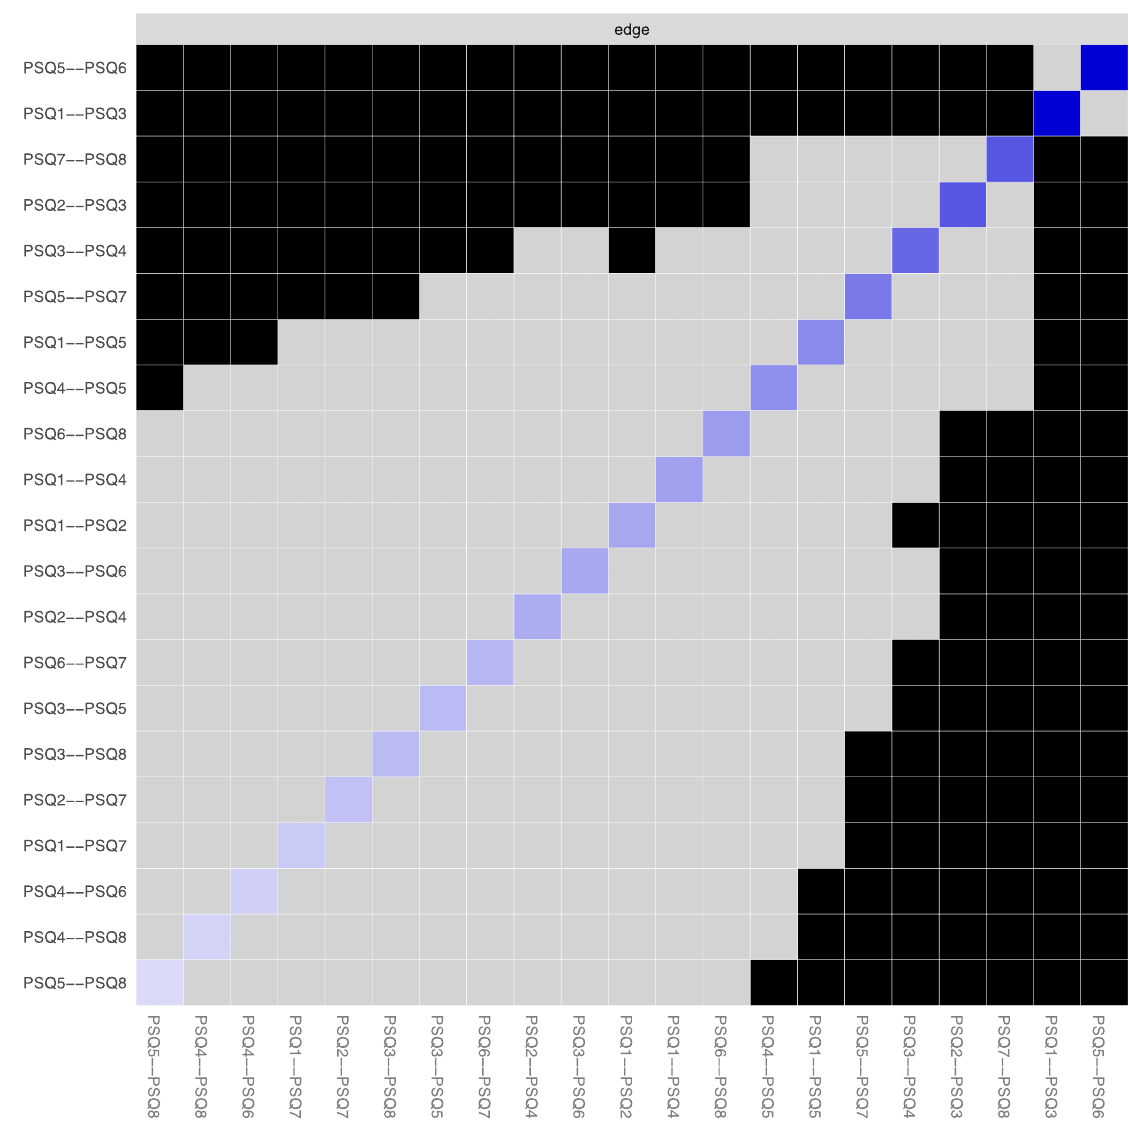
Figure 5. Bootstrapped edge weights difference test. Note: This test signifies the bootstrapped significance between pairwise edges in the global PSQ network for every pairwise node comparison (α = 0.05). Significant differences are depicted by black boxes and non-significant differences by grey boxes, while the diagonal-coloured boxes refer to the strength of the edge weight in the network plot (darker blue represents stronger connection).